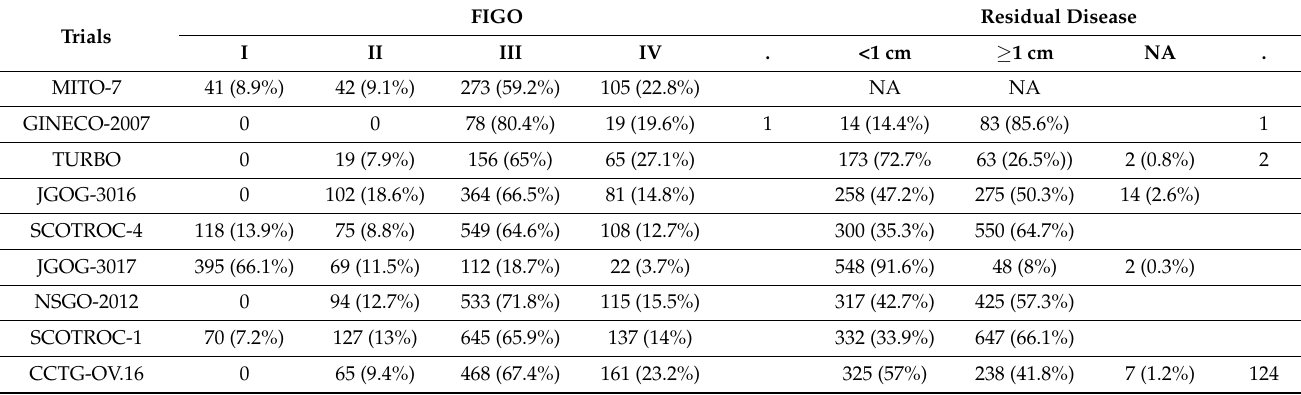
Table 2. Patients’ characteristics by trial (N = 5209).